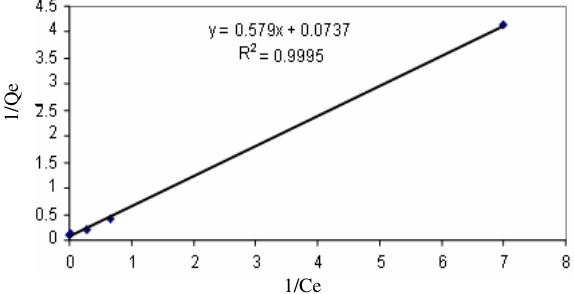
Figure 6. Linearised Langmuir Isotherm plot of cadmium